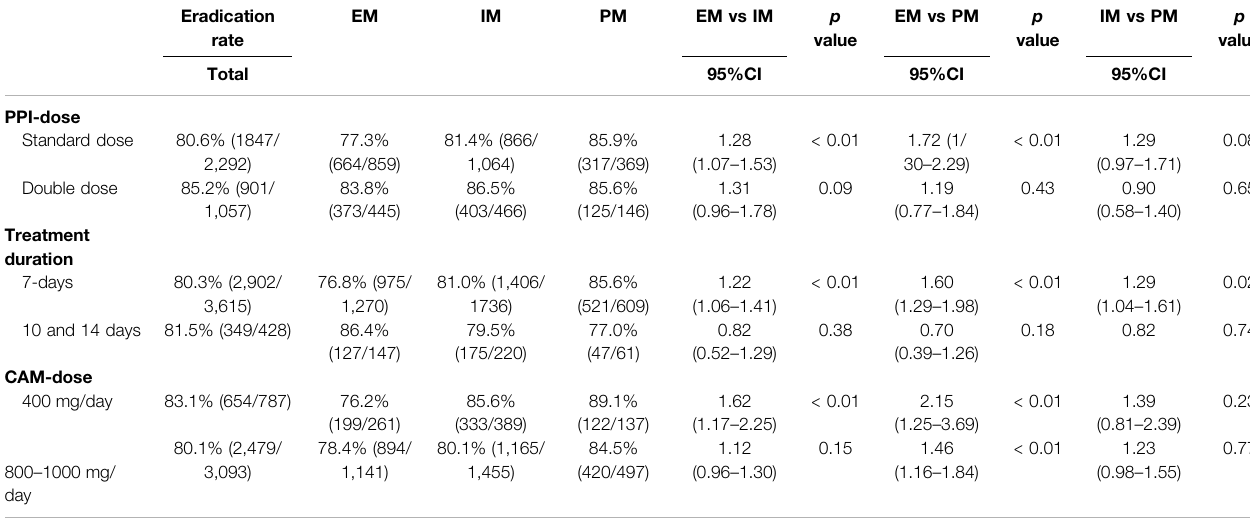
TABLE 4 | Effect of CYP2C19 genotypes on the eradication rate of PPI-based triple therapies among different dose of PPI, among different duration of eradication and different dose of CAM. Eradication